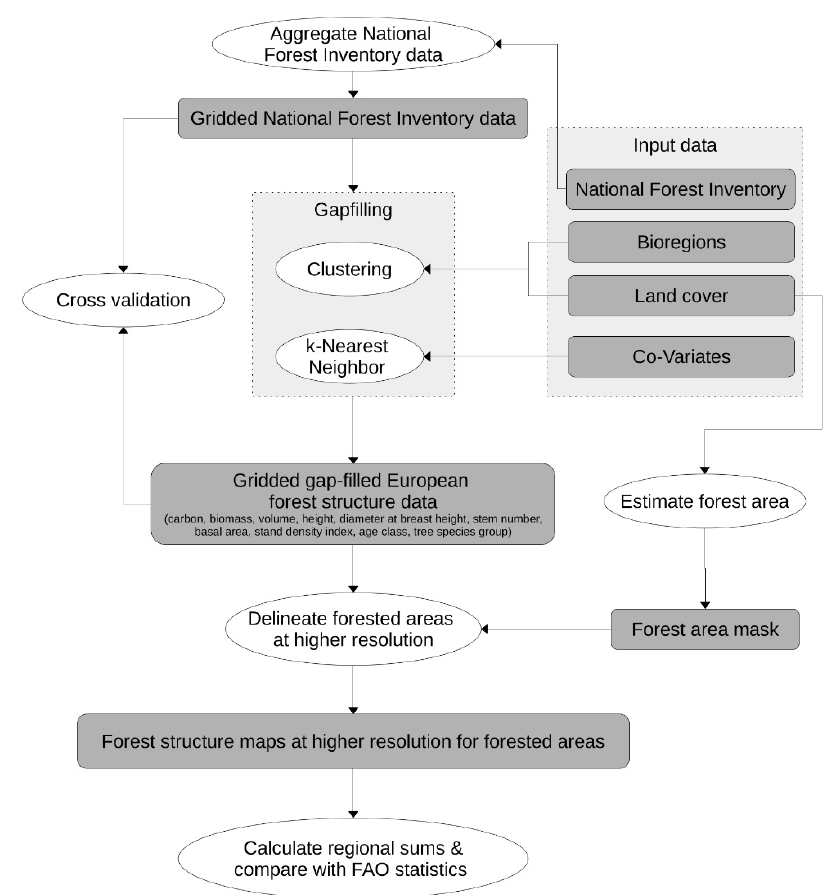
Figure 1. Flow-chart for the methodology to derive a gridded gap-filled forest structure dataset from individual NFI plot tree data across Europe. Grey, round-edged boxes represent input and output data and ellipses calculation steps. Light grey, dotted boxes summarize grouping of the input data and the two-step gap-filling algorithm.